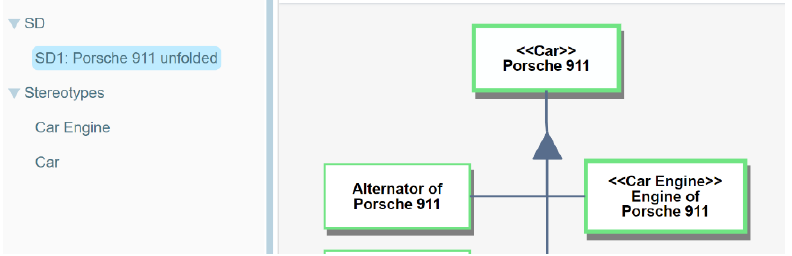
Figure 10. Porsche 911 with <<Car>> and <<Car Engine>> stereotypes.